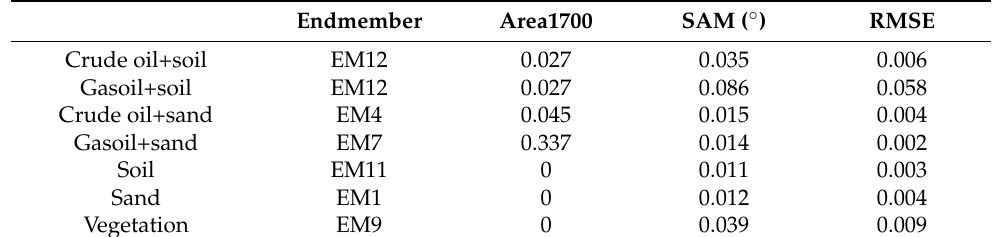
Table 3. Area1700 values of endmembers (values of the remaining endmembers are equal to 0), spectral angle values between each component and the closest endmember (considering spectral angle), and the corresponding RMSE. Case OPSv1: OSP applied to the image where the bottom part of the image showing vegetation has been removed, but without vegetation rejection test.